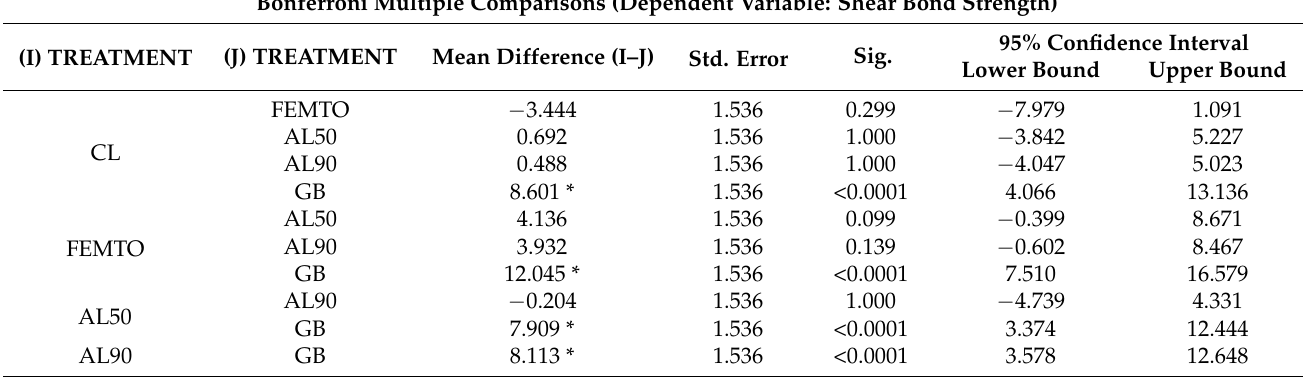
Table 1. Bonferroni Multiple Comparison tests of shear bond strength values among the groups. Bonferroni Multiple Comparisons (Dependent Variable: Shear Bond